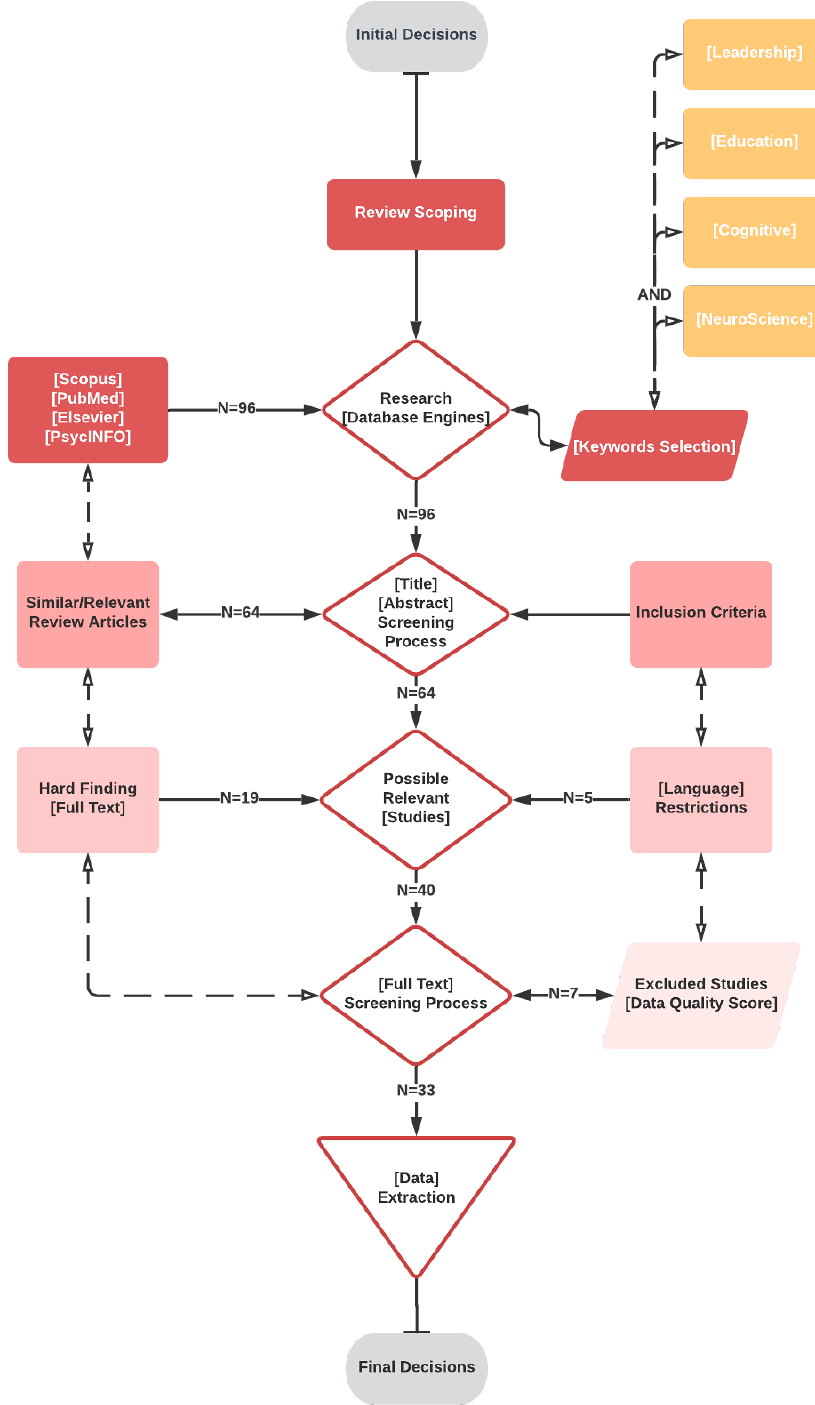
Figure 2. Systematic Review